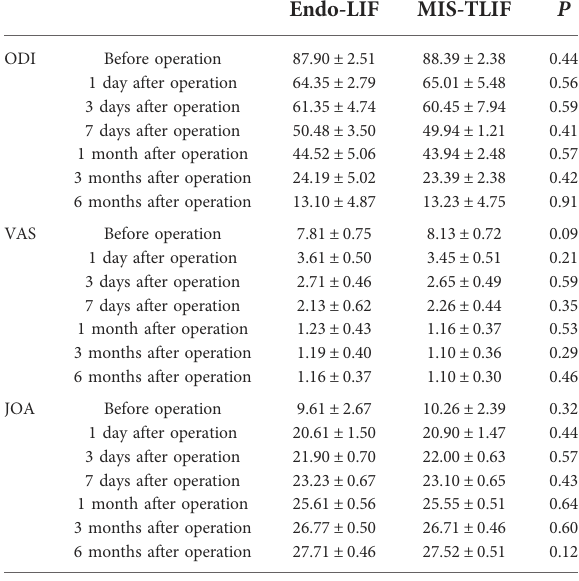
TABLE 2 Comparison of clinical outcomes between the two groups in perioperative period.